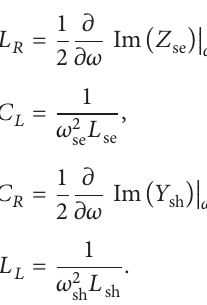
Figure 4. When we have zero immittances, the series reso- nance frequency 𝜔 se and parallel resonance frequency 𝜔 sh are